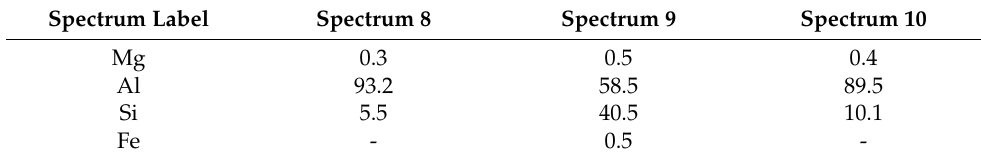
Table 2. Quantitative EDS analysis of the spectra in Figure